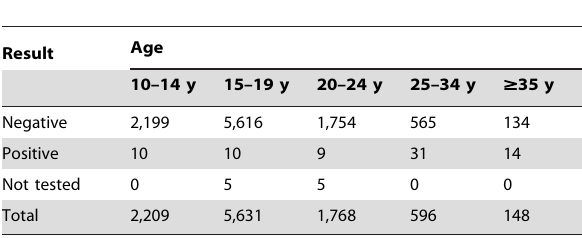
Table 3. HIV testing, by age